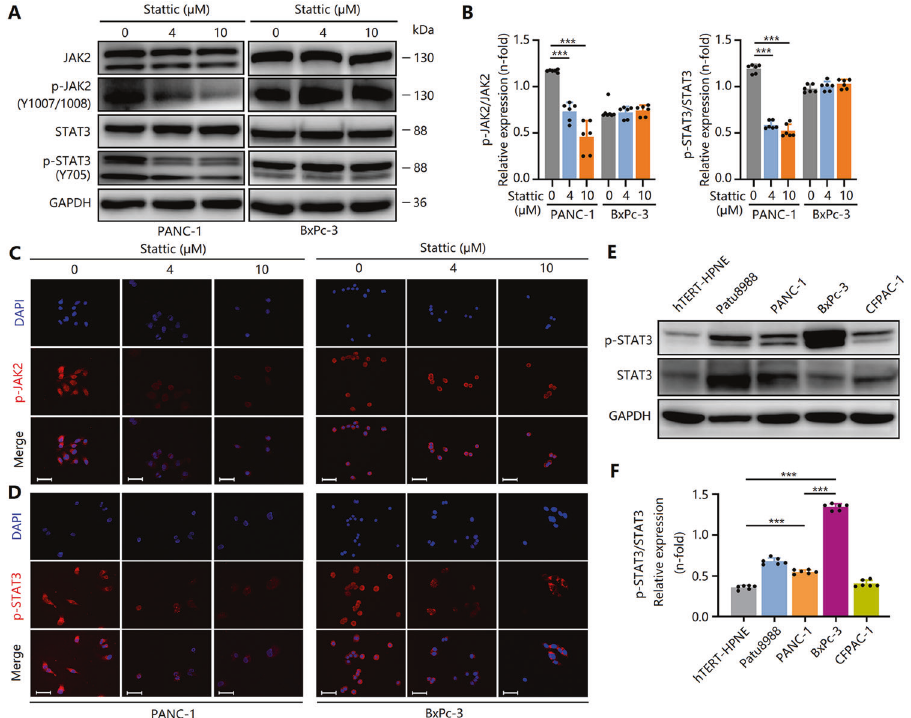
Fig. 5 Stattic selectively antagonizes STAT3 Y705 phosphorylation and inactivates STAT3 in PCCs. PCCs were treated with 4 and 10 μ M of Stattic for 24 h. A , B Expression and phosphorylation of JAK2 and STAT3 in Stattic-treated BxPc-3 and PANC-1 cells. C , D Immunocytochemical staining of p-JAK2 and p-STAT3 in Stattic-treated PANC-1 and BxPc-3 cells. Bar = 50 μ m. E , F Expression and phosphorylation of STAT3 in different PCCs. Data are shown as the mean ± standard deviation. *** P <